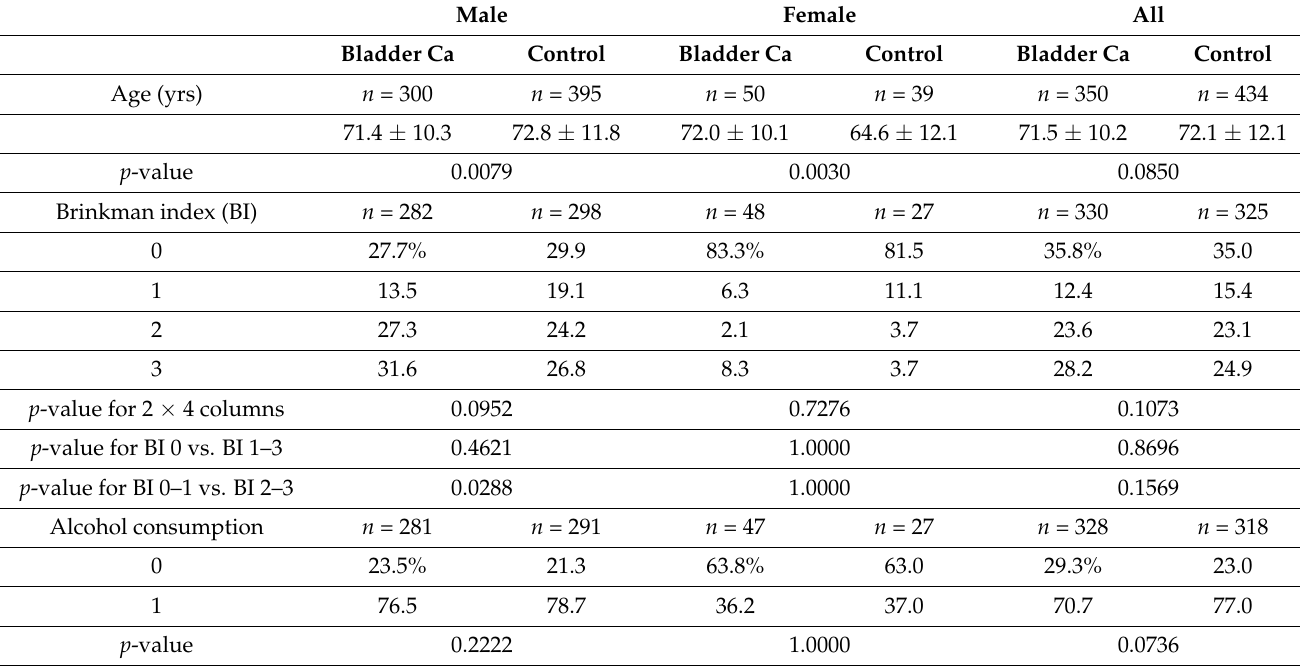
Table 1. Clinical and environmental factors.